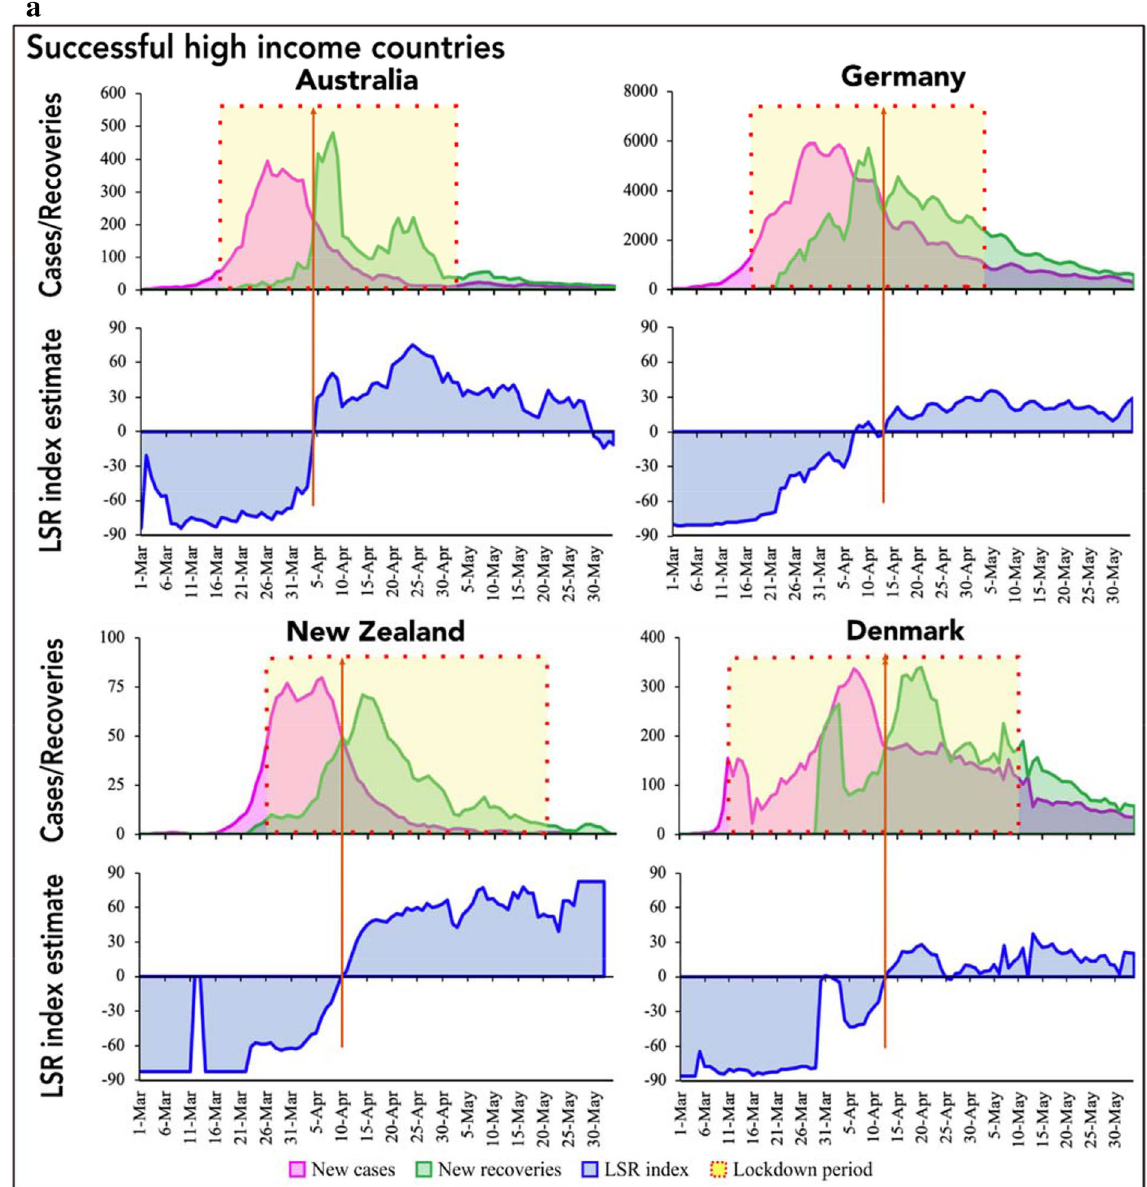
Figure 1. ( a ) Infection-recovery (top panel) and the corresponding LSR index (bottom panel) trajectories in the successful high-income countries (Part a). ( b ) Infection-recovery (top panel) and the corresponding LSR index (bottom panel) trajectories in the successful high-income countries (Part b). The brown vertical line indicates the day of infection-recovery